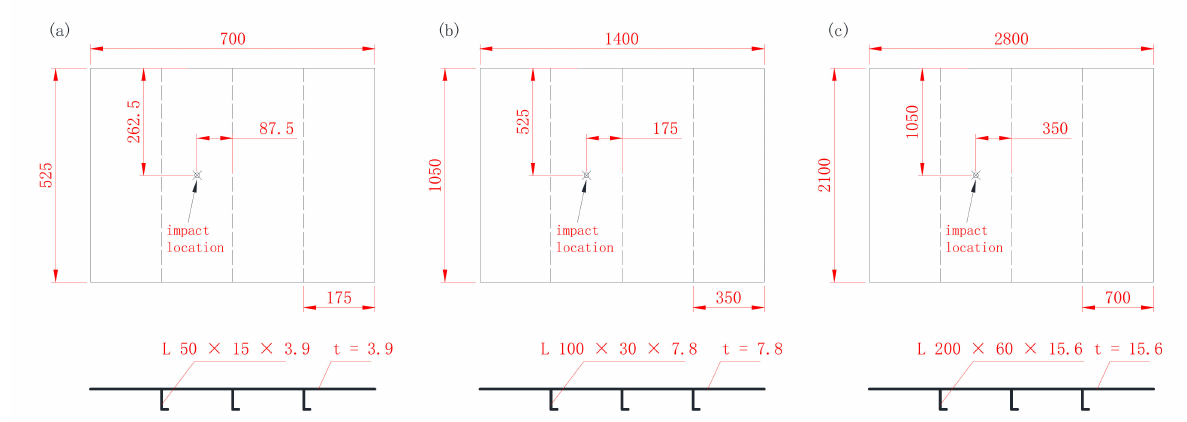
Figure 1. Geometric configurations of the geometrically similar stiffened plates (unit: mm): ( a ) 1:4 scaled; ( b ) 1:2 scaled; ( c ) full-scaled (“L” means that the stiffeners are angle steel with “L” shaped cross-section, “t” means thickness of the plate).